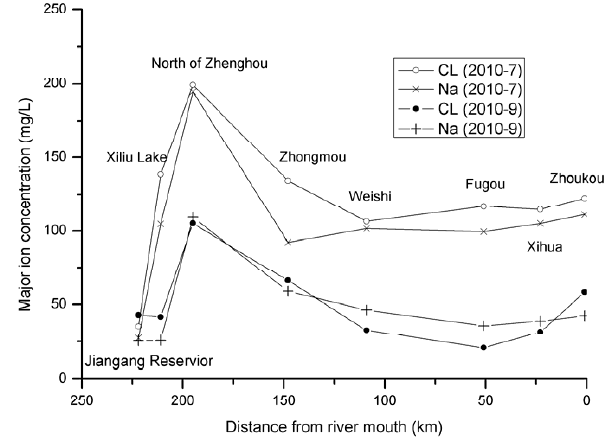
Fig. 8. Major ion concentration/distance from river mouth profiles Fig. 8 for chloride and sodium in the main stream of the